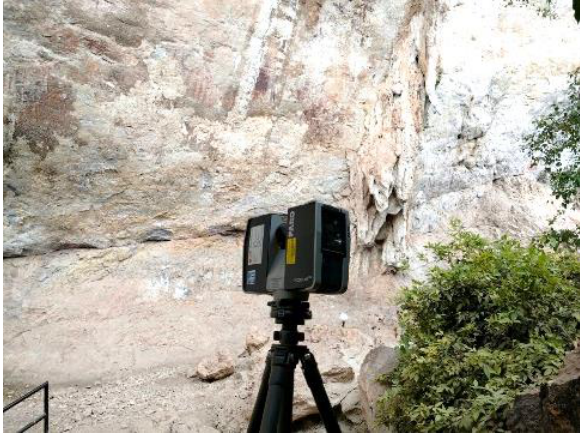
Figure 3: The Faro Focus 3D TLS used in the